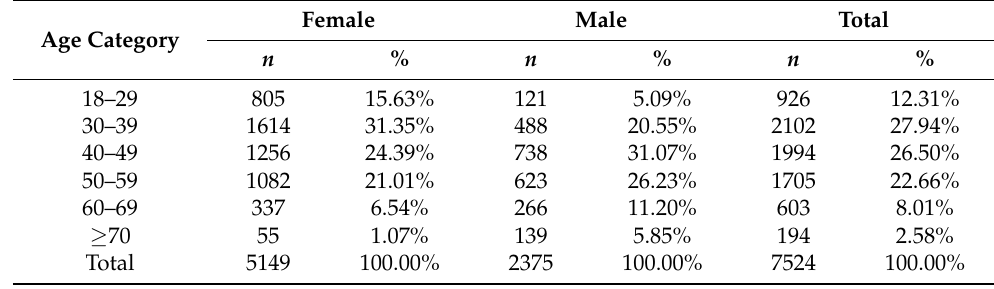
Table 1. Number and share of patients who were prescribed more than one antibiotic during a single visit according to the patients’ age and sex.